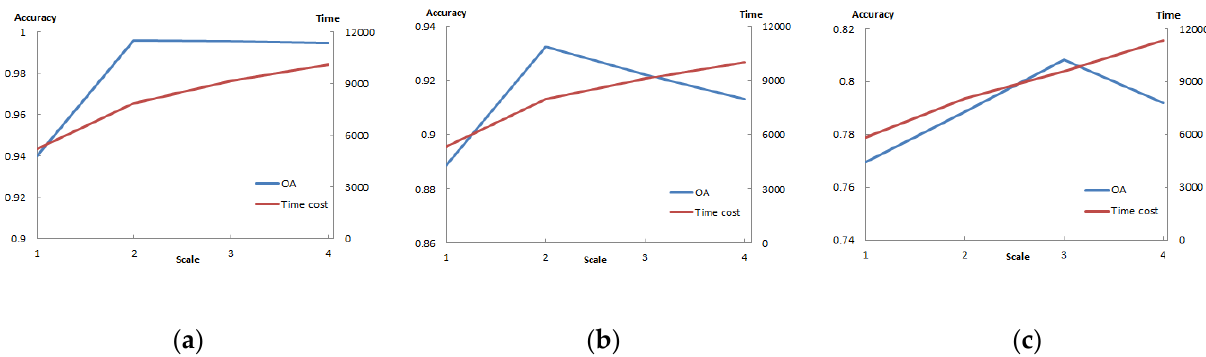
Figure 13. The OA and time costs of the three experiments with the different divided scales: ( a ) the line chart of the OA and time costs influenced in the simulated data, ( b ) the line chart of the OA and time costs influenced in the real data 1 and ( c ) the line chart of the OA and time costs influenced in the real data 2.